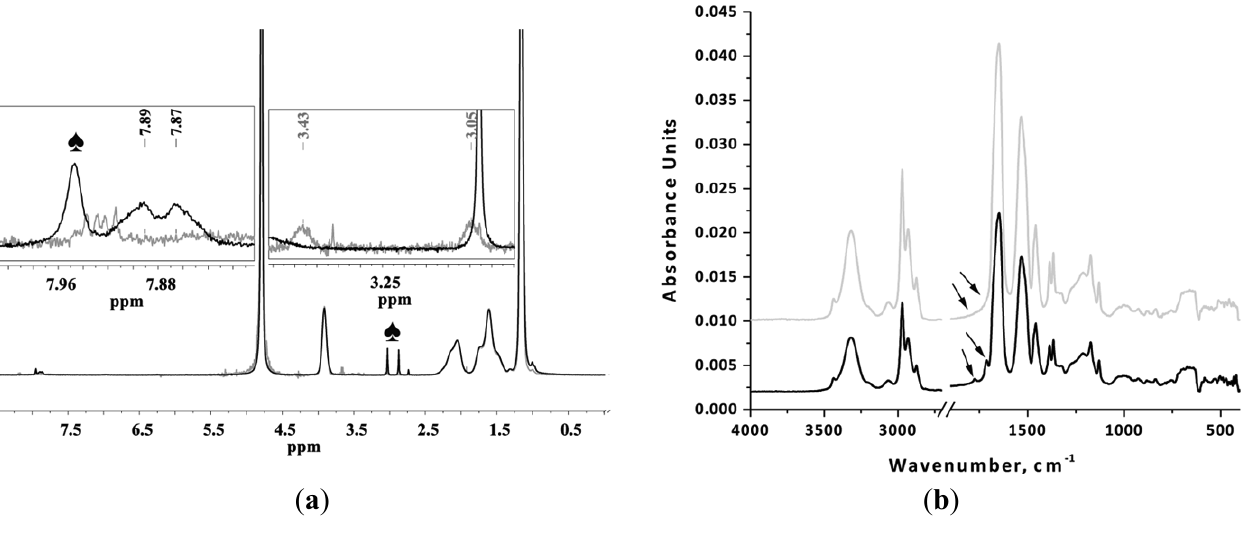
Figure 2. ( a ) 1 H-NMR and ( b ) FTIR spectra of PNIPAAm before (black) and after (grey) removal of phthalimide-protecting group. 1 H-NMR spectra were recorded in D number of scans ~ 32, relaxation delay 12 s (♠, residues of